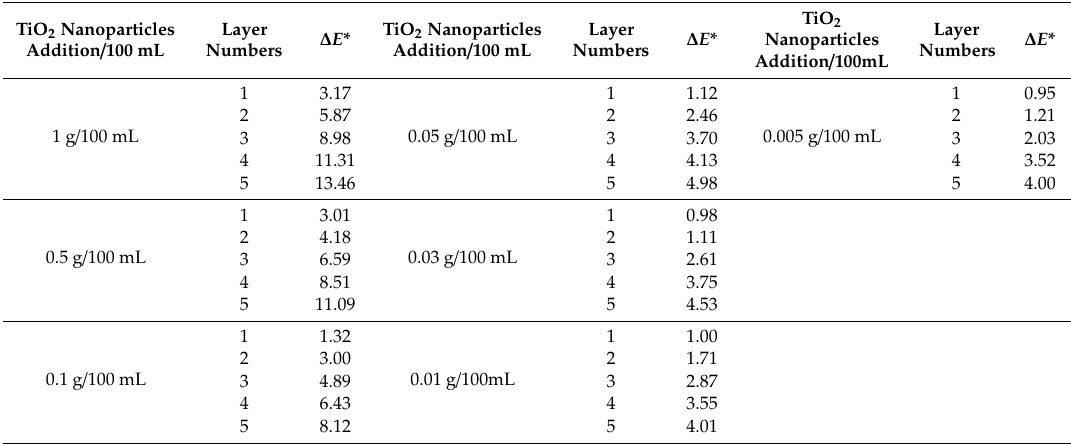
Table 2. E ff ect of amount of TiO 2 nanoparticles and the layer numbers on color di ff erence. TiO 2 Nanoparticles Addition / 100